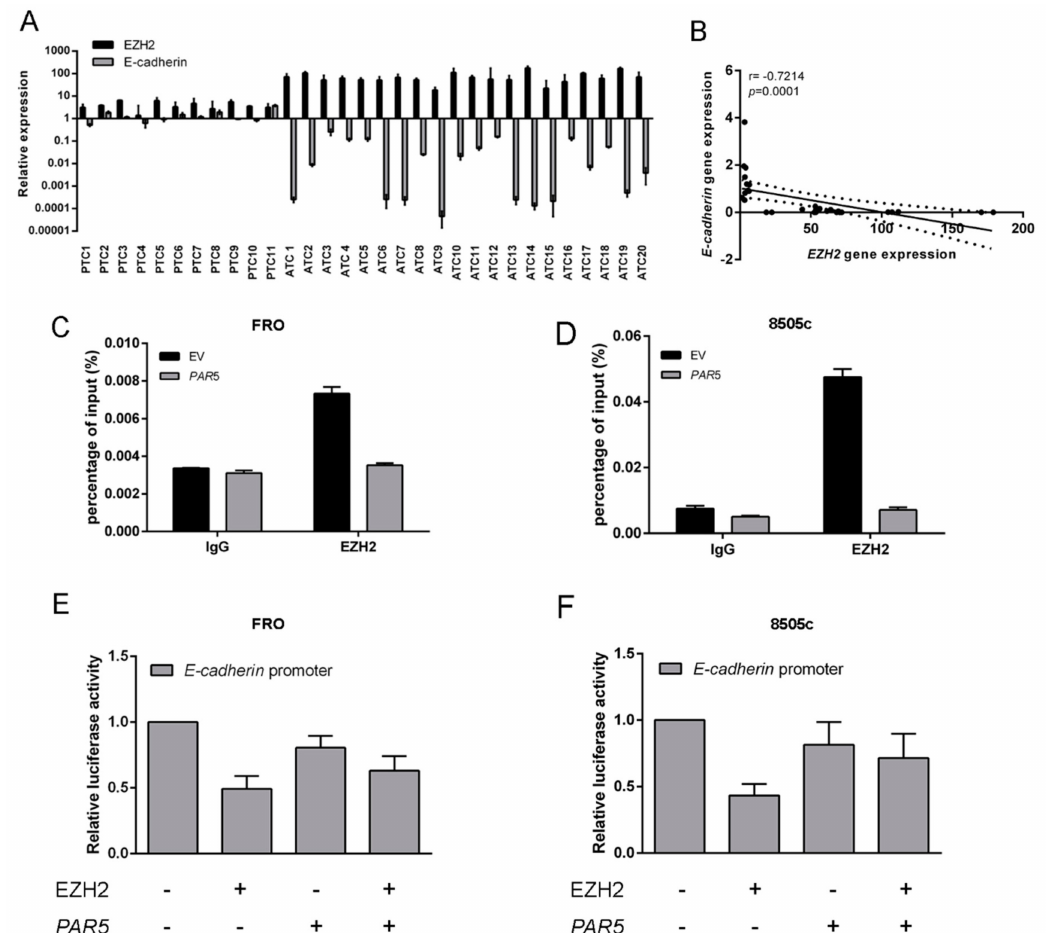
Figure 6. PAR5 interacts with EZH2 reducing its binding to E-cadherin promoter. ( A ) qRT-PCR analysis was performed in 11 PTC and 20 ATC samples to evaluate the expression levels of EZH2 and E-cadherin. ( B ) Correlation scatter plot (Spearman’s Rank) between EZH2 and E-cadherin mRNA levels analyzed in all patient’s carcinoma samples ( r = − 0.7214; p = 0.0001). ( C , D ) Chromatin immunoprecipitation (ChIP) assay was carried out in FRO and 8505c cells transiently transfected with PAR5 or the corresponding EV. ATC cell lines were then crosslinked, sonicated, and subjected to pre-clearing. The chromatin was immunoprecipitated using antibodies against EZH2. IgG were used as negative control. The immunoprecipitated chromatin was analyzed by qPCR assay with primers specific for the E-cadherin promoter. ( E , F ) Luciferase assays performed in ATC cells transfected with the E-cadherin -luc vector and with single or both vectors expressing EZH2 or PAR5 . The total amount of the transfected DNA was balanced with the EV. Relative E-cadherin luciferase activity was compared to that observed in cells transfected with the only EV, assuming that the control is equal to 1. Values are the mean of three independent experiments ±